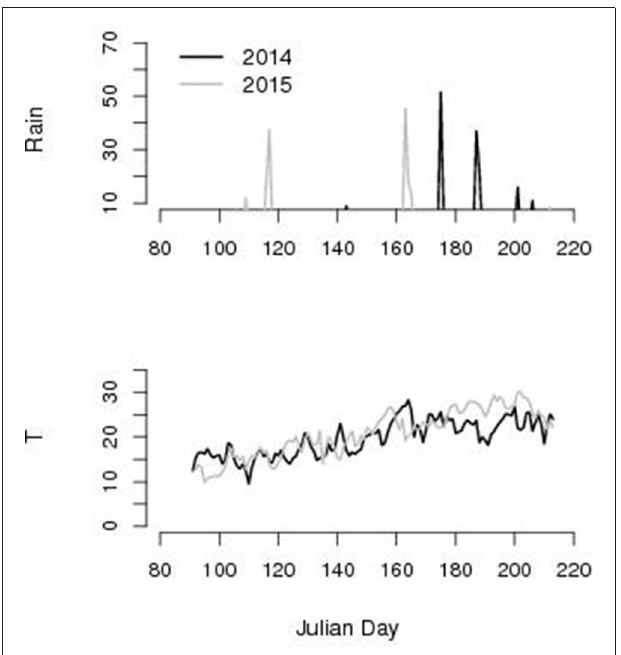
FIGURE 4 | Rain (mm) and average daily temperature T ( ◦ C) along Julian day left column. We found 9 favorable days in 2014 and 0 in 2015 for brown rot spreading (rainy and 22 < T < 26 ◦ C) for the two seasons experiment during the window of fruits susceptibility (JD 173–198 in 2014 and 185–209 in 2015).